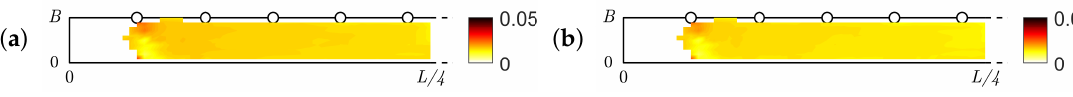
Figure 30. Uncertainty of the trajectories obtained by the drone by representation of the time and pedestrian-averaged smoothed state uncertainty matrix ΣΣΣ k N : 95% distance of the uncertainty in the | horizontal direction of the estimated state (depicted for half a bridge deck): walking in case of ( a ) mono, ( b ) mono using the EKF with the corresponding color scale expressed in meters. The white space corresponds to places where no operational data is